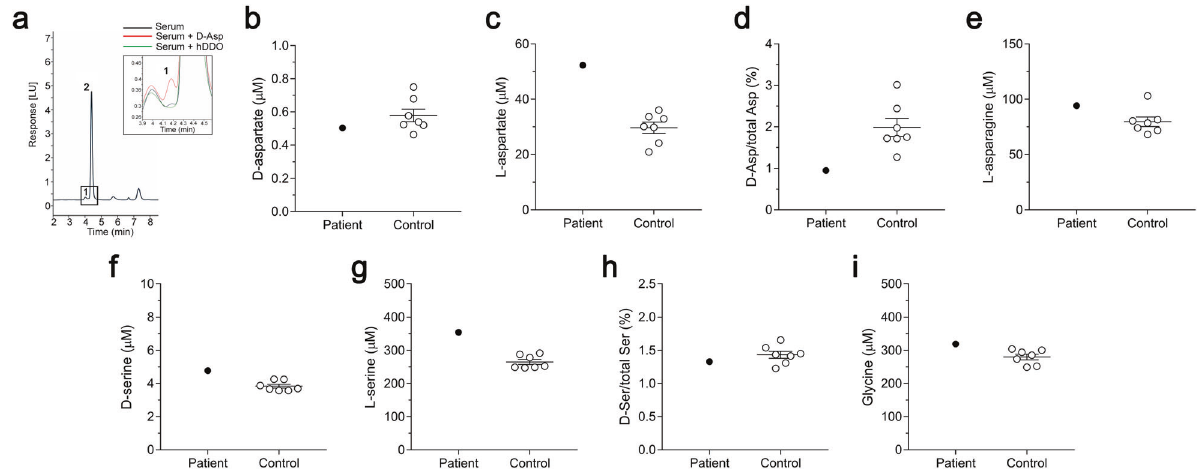
Fig. 4 Determination of D-aspartate, L-aspartate and other amino acids content in blood serum sample of the patient. a Overlaid HPLC chromatograms illustrating the speci fi city of D-aspartate (D-Asp) peaks obtained from blood serum samples. The identity of the peak corresponding to D-aspartate was veri fi ed by treating serum sample with hDDO (inset, green line) or by adding the external standard to serum sample (inset, red line). b – i Amount of ( b ) D-aspartate, ( c ) L-aspartate, ( d ) D-aspartate/total aspartate (D + L) ratio, ( e ) L-asparagine; ( f ) D- serine, ( g ) L-serine, ( h ) D-serine/total serine (D + L) ratio and ( i ) glycine in the serum of the patient with DDO gene duplication, compared to gender- and age-matched healthy subjects ( n =